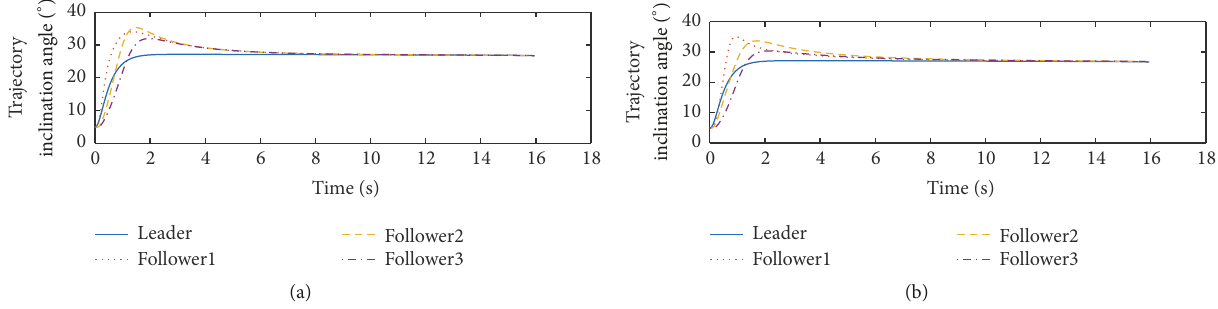
Figure 6: Trajectory inclination angle curve in the global and local communication topologies: (a) trajectory inclination angle curve in the global communication topology; (b) trajectory inclination angle curve in the local communication topology.